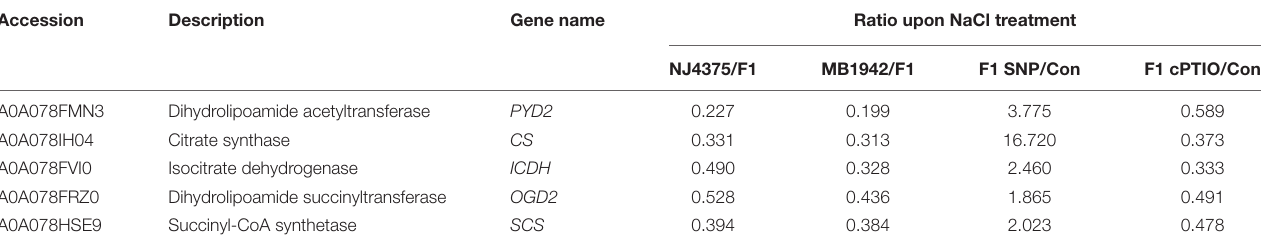
TABLE 4 | List of TCA cycle-related proteins in the seedling leaves of B. napus materials in response to salt stress for 3 days with or without SNP or cPTIO pre-treatment for 12